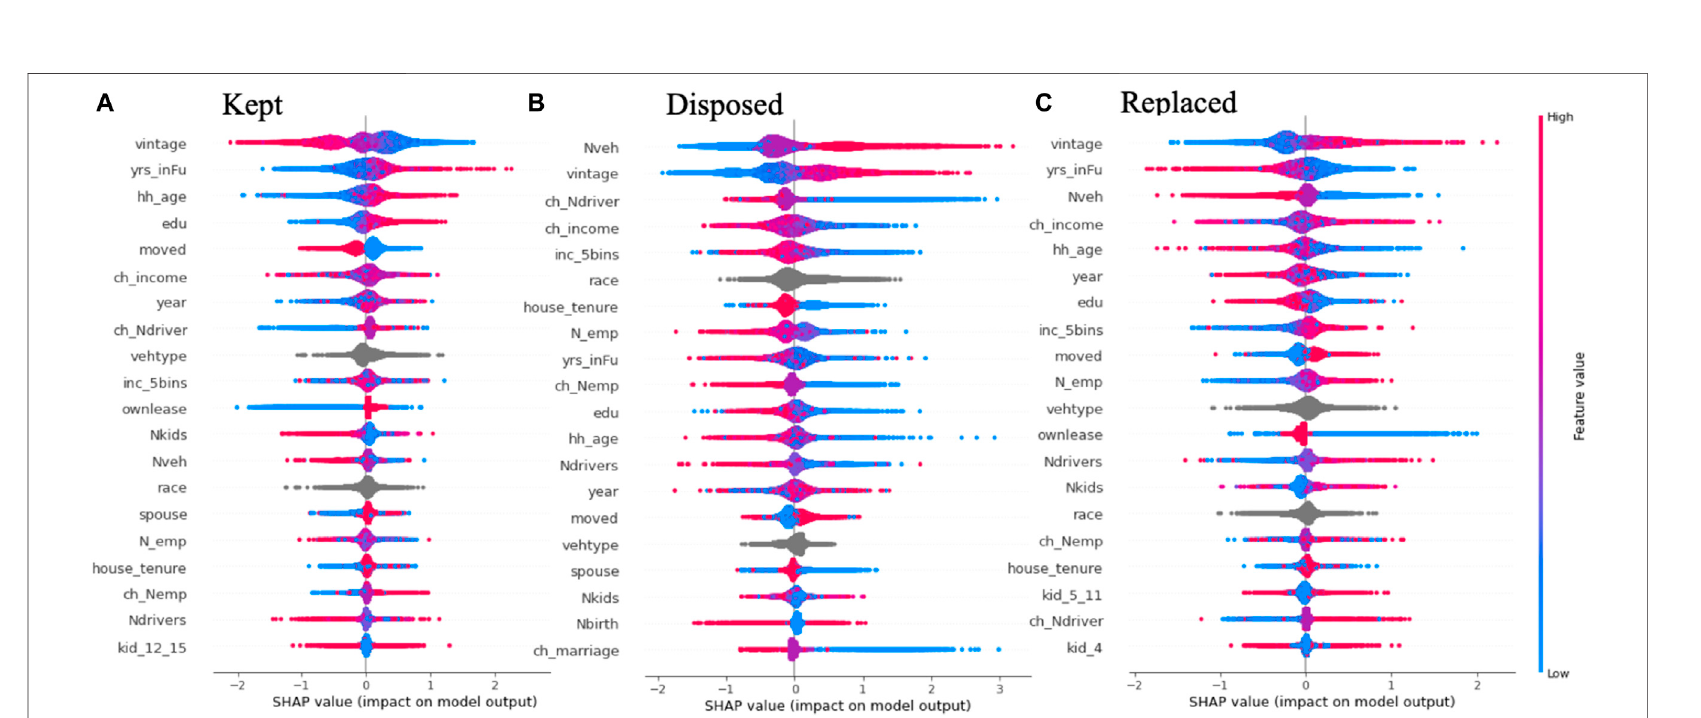
FIGURE3| Localexplanationsummary,i.e.,variables ’ impactontheoutcomeclass (A) kept, (B) disposed,and (C) replaced.The25mostimportantinputvariablesareshownforeachoutcomeclassandvariables are ranked (from top to bottom) by their global importance measured by the average absolute SHAP value. See Table 1 for description of variable